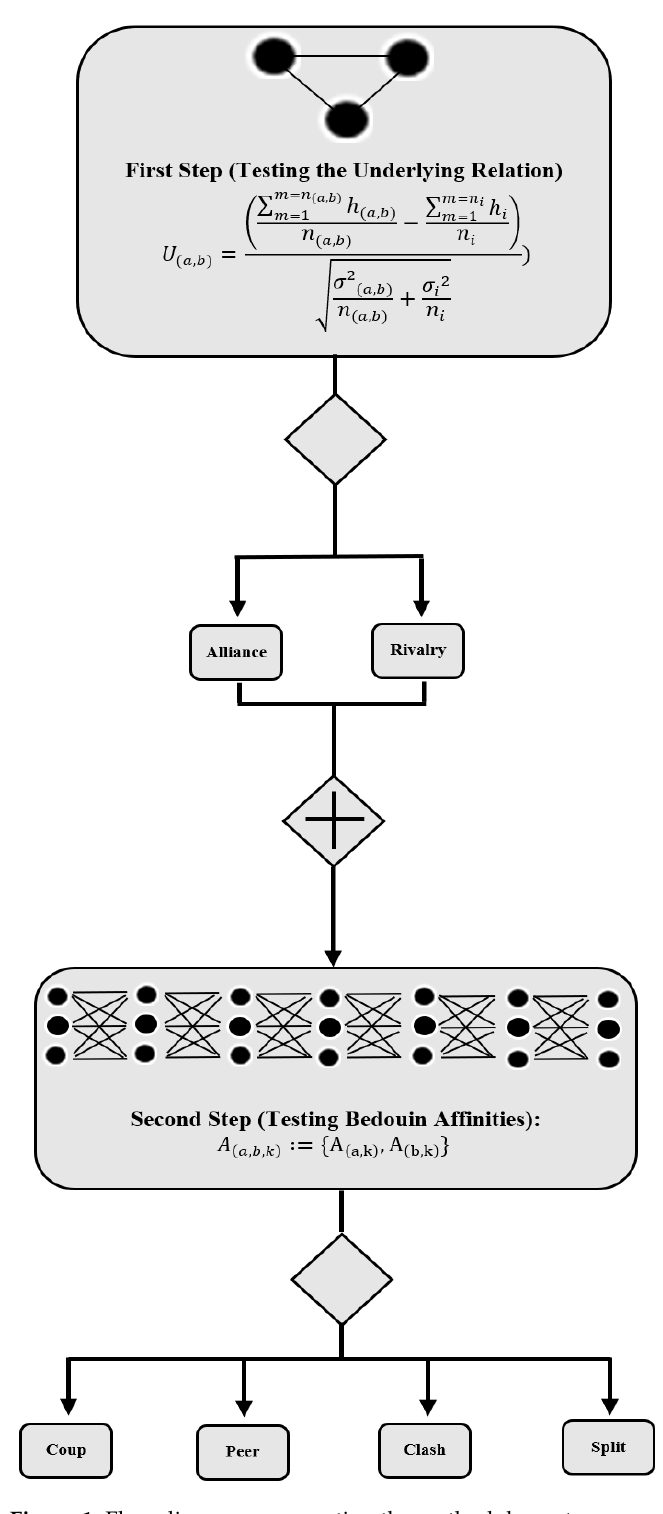
Figure 1. Flow diagram representing the methodology steps.